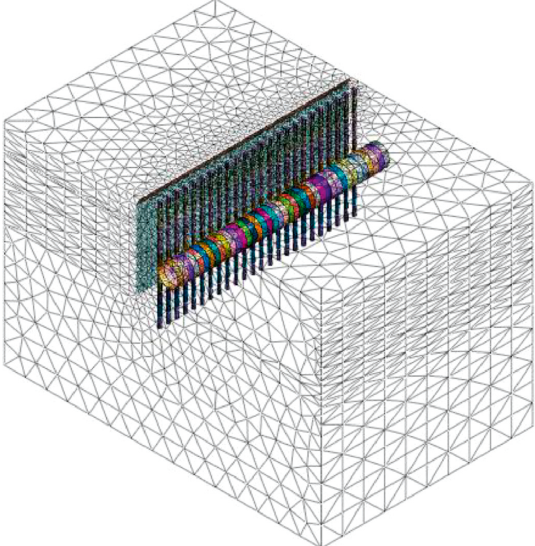
Figure 9: Mesh of the numerical calculation model.